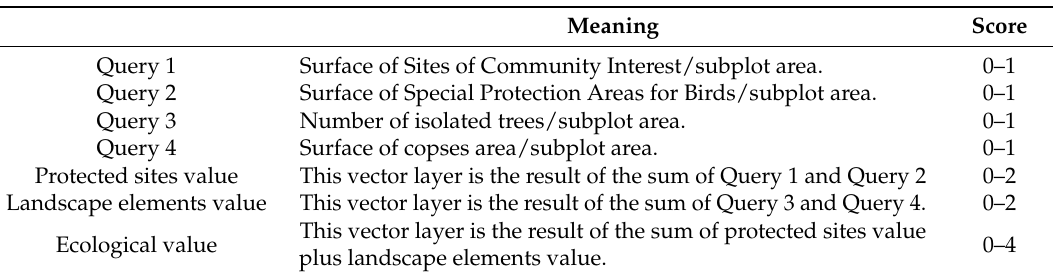
Table 4. Queries for generating the ecological value